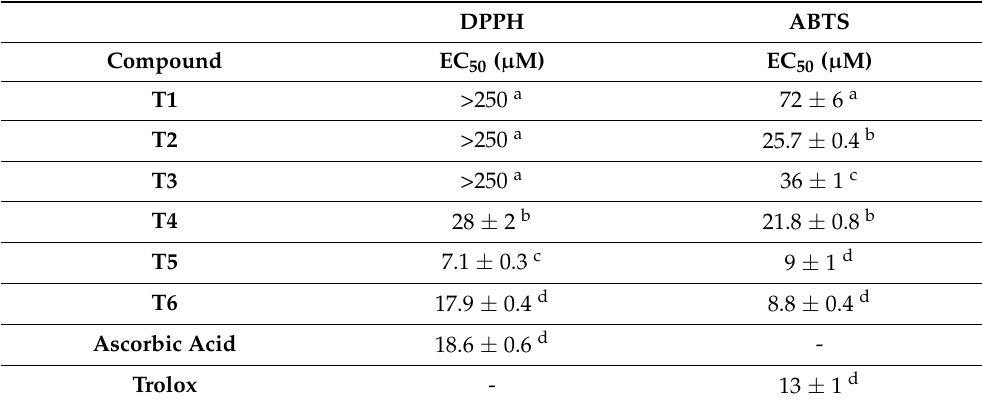
Table 1. EC 50 values for the studied compounds determined from the antioxidant assays. Ascorbic acid and Trolox were used as reference